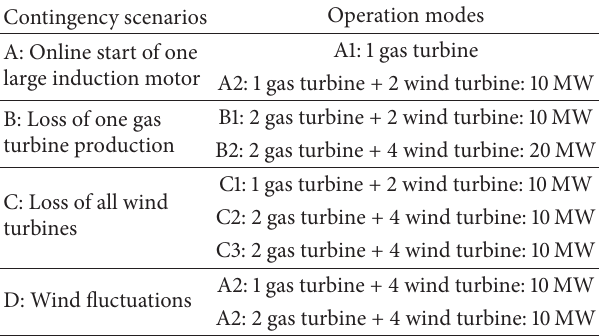
Table 3: Nine dynamic simulation